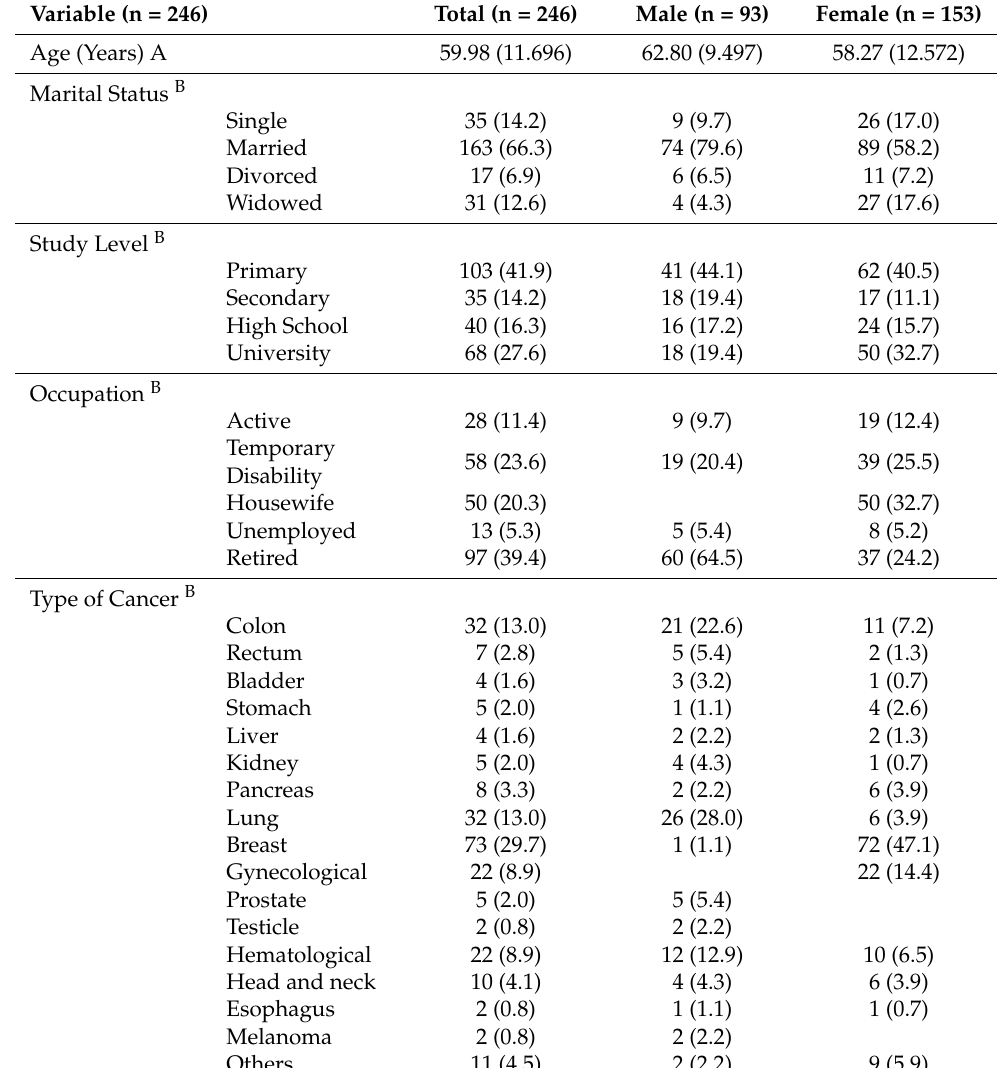
Table 1. Socio-demographic data of the complete sample and by